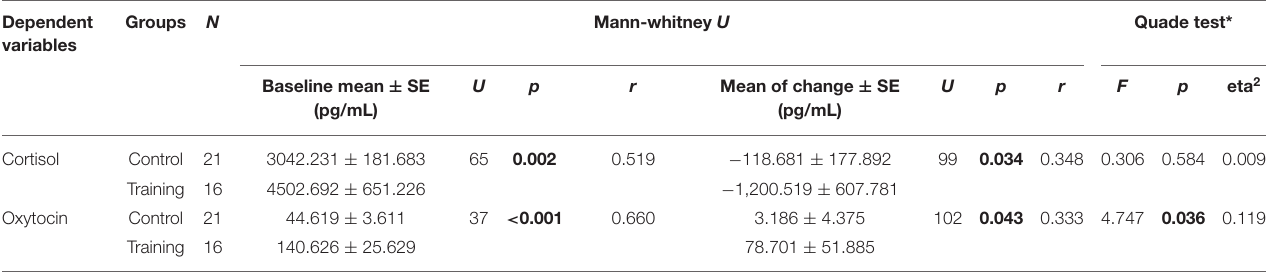
TABLE 3 | Group differences on changes in salivary cortisol and oxytocin levels. Dependent